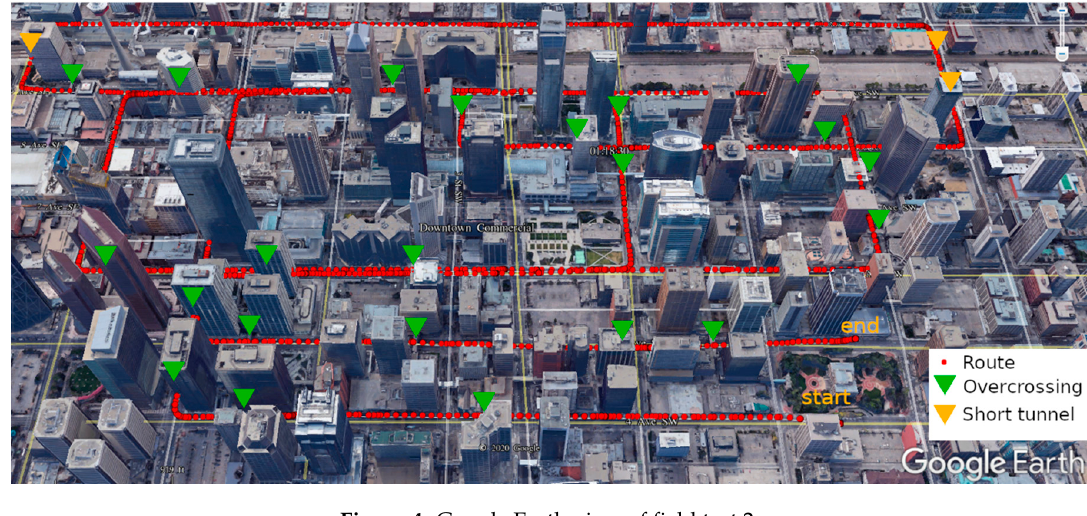
Figure 3. Google Earth view of field test 1.